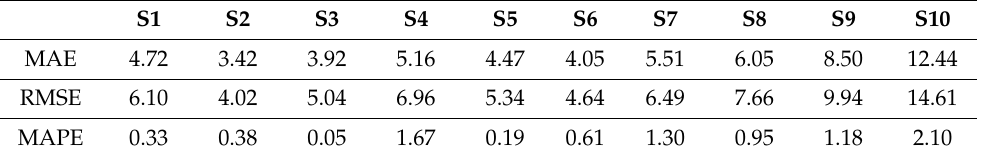
Table 5. Goodness of fit indicators for the regional series modeling.